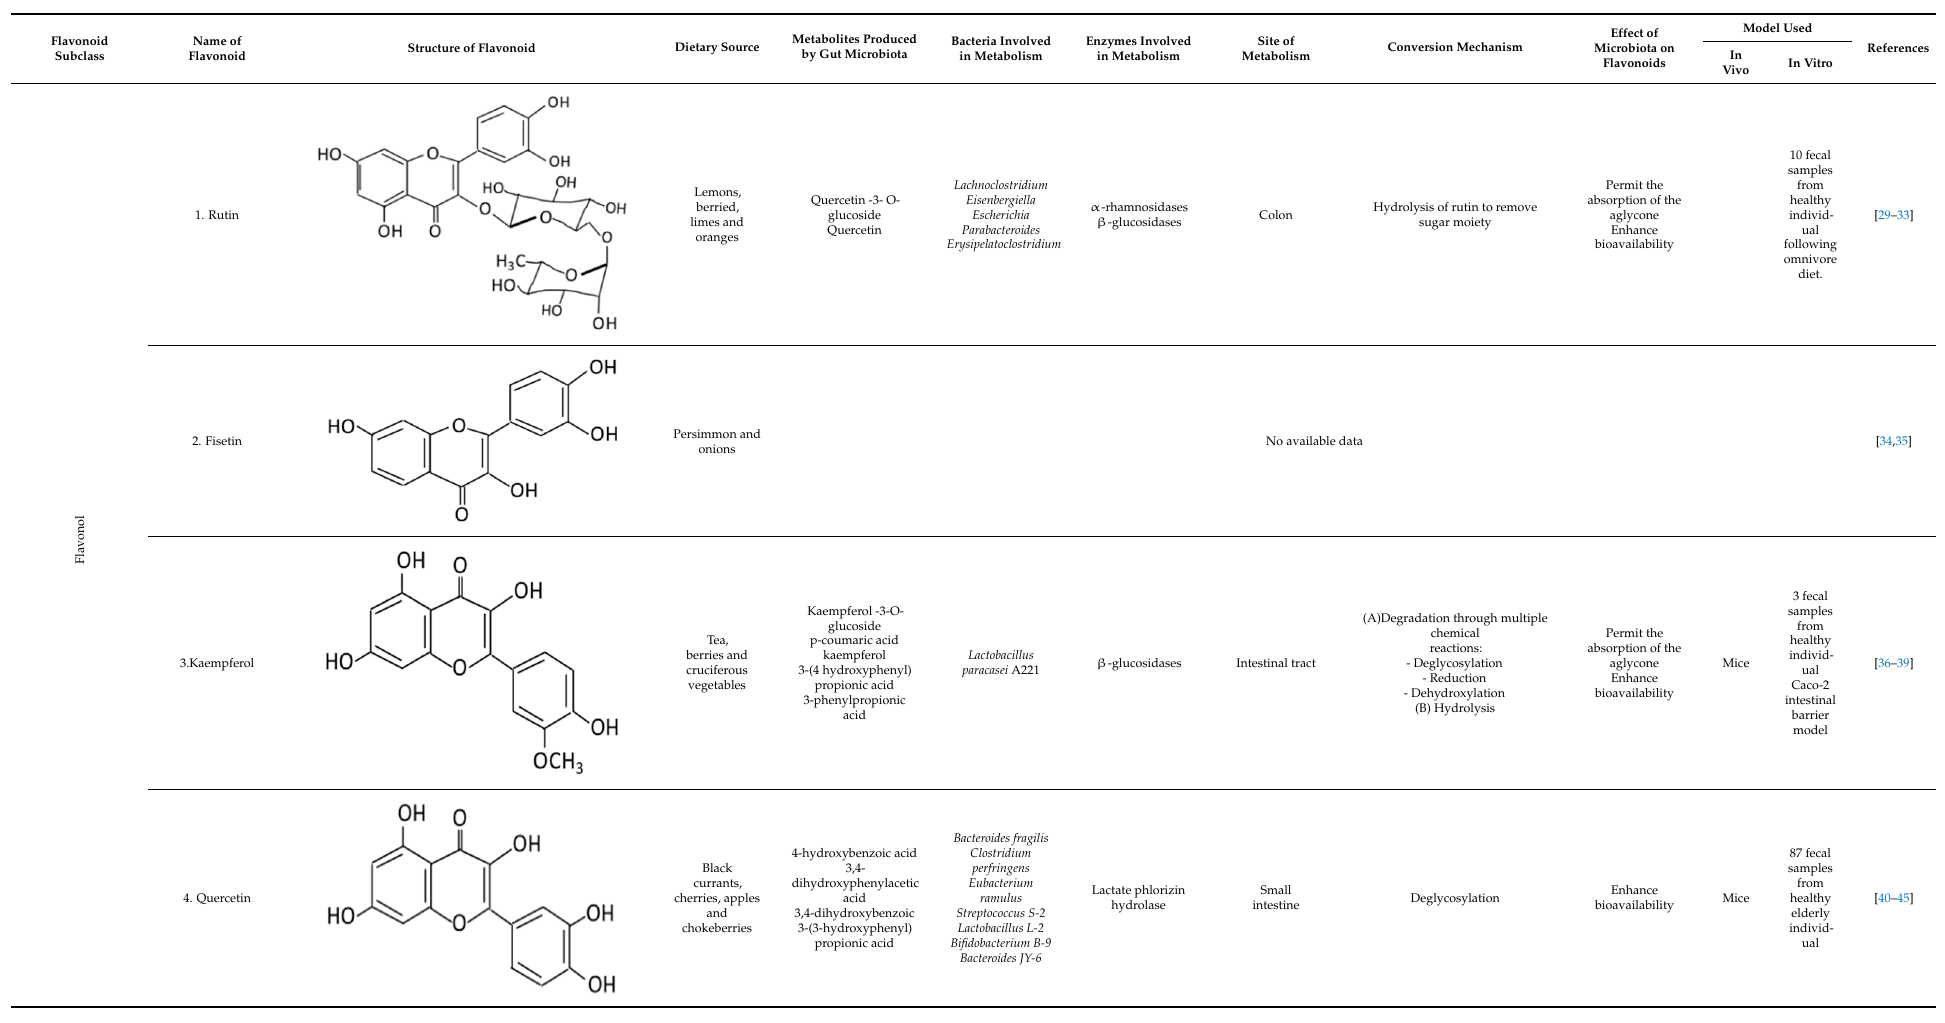
Table 1. Representative Flavonoids and their Underlying Metabolism by Gut microbiota.